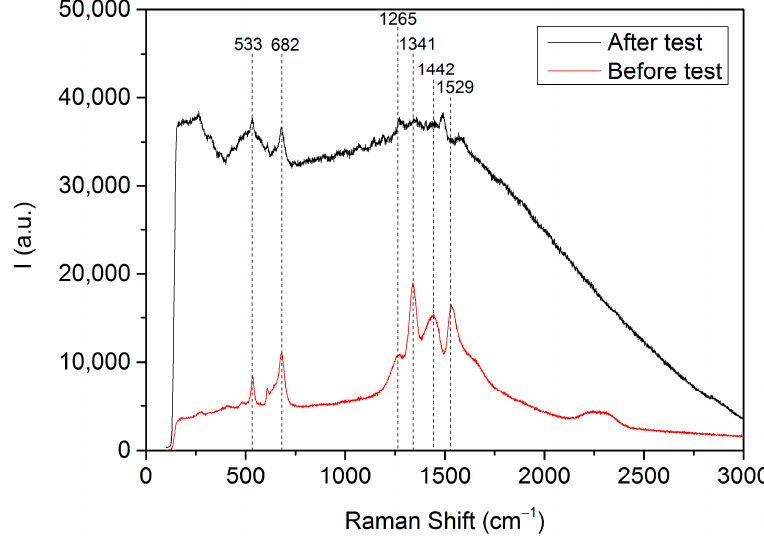
Figure 9. Raman spectra of the Fe 0.7 Cr 1.3 O 4 /8YSZ electrode layer with a gold collector after and before test.